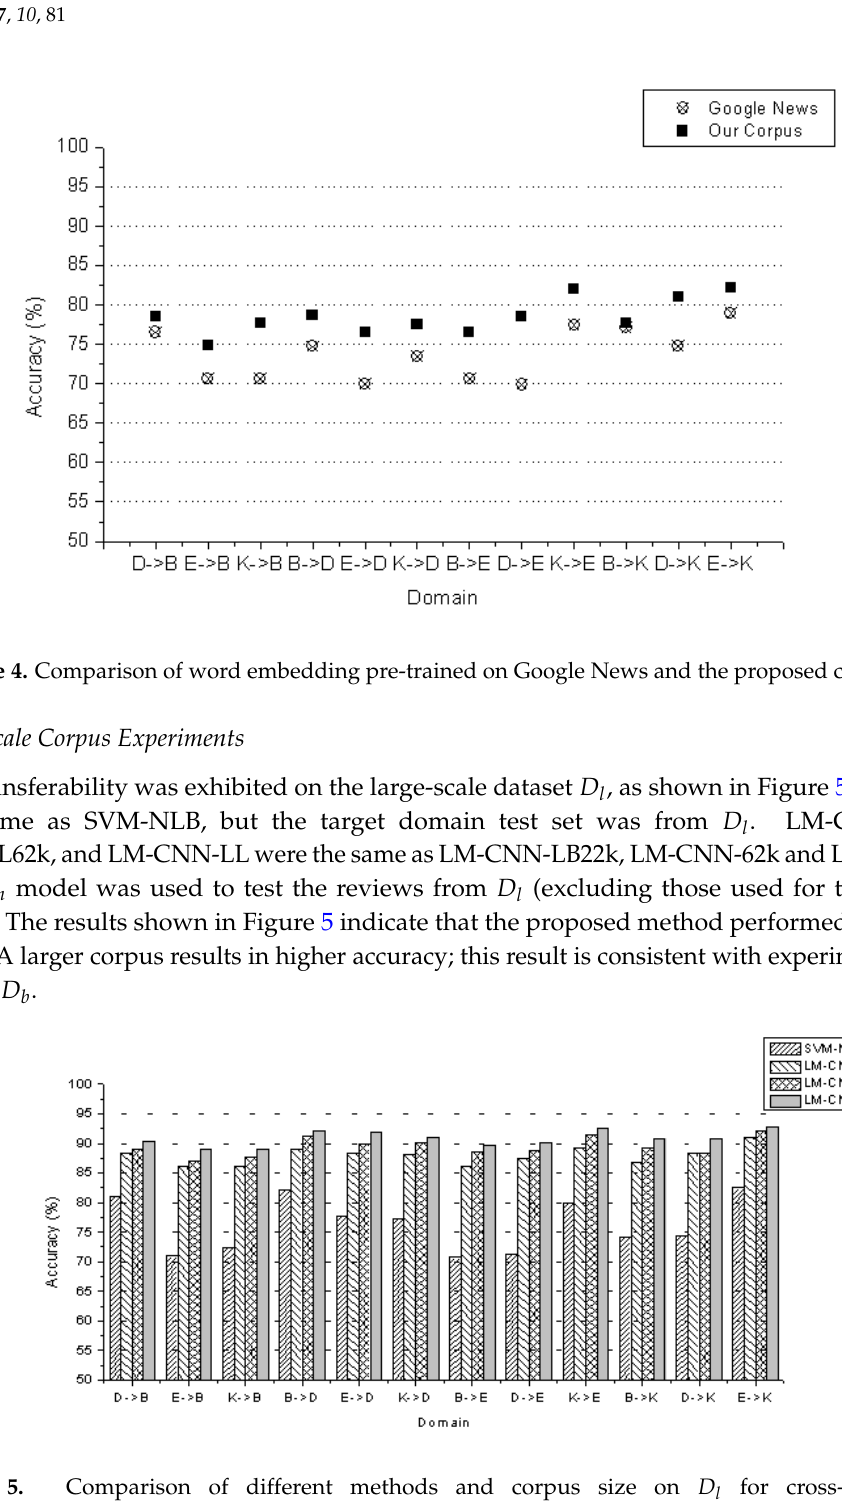
Figure 5. Comparison of different methods and corpus size on D l for cross-domain sentiment